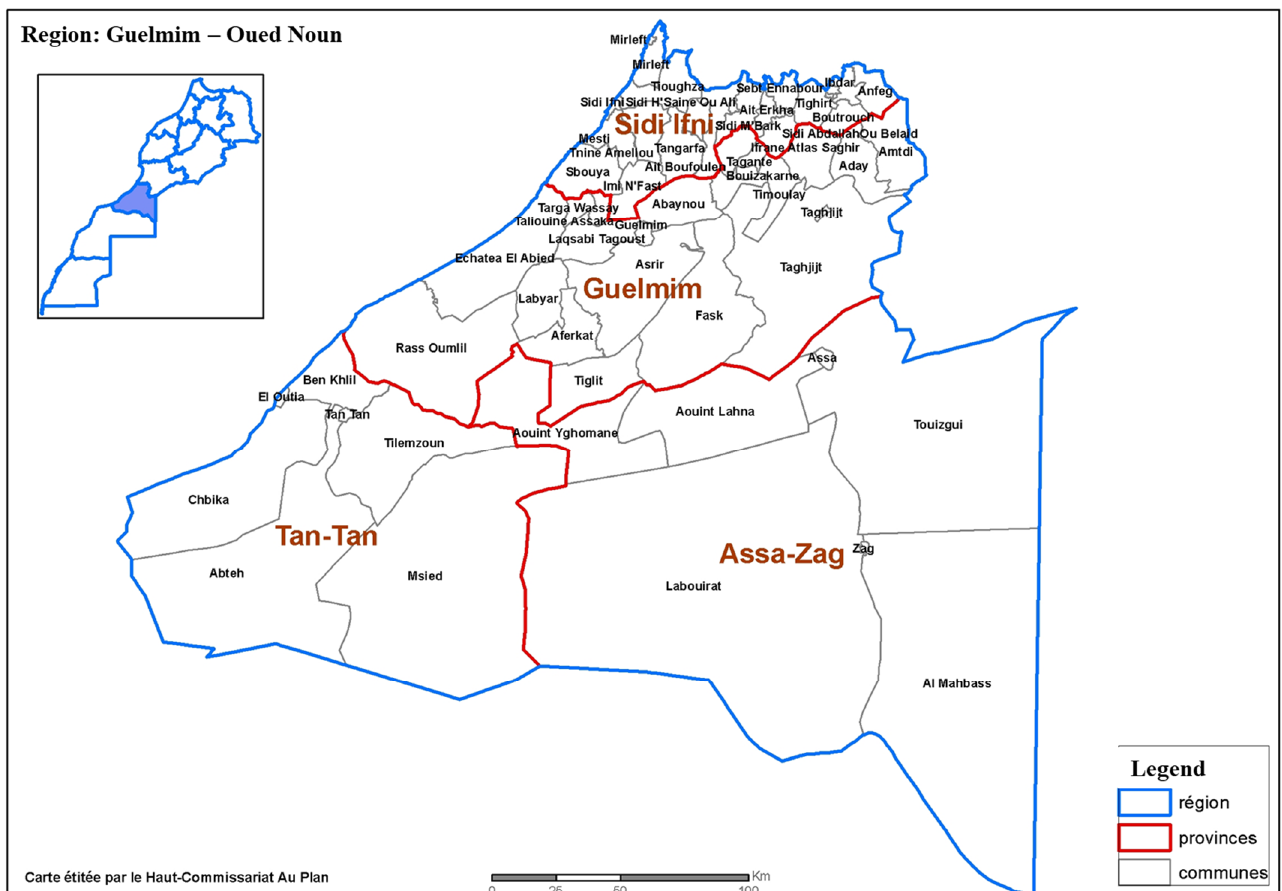
Figure 1. Map of the province of Guelmim and boundaries of the study area; High commission for planning–Guelmim regional directorate. (https://www.hcp.ma/region-guelmim/Presentation-de- la-region_a1.html (accessed on 1 April 2021)) .